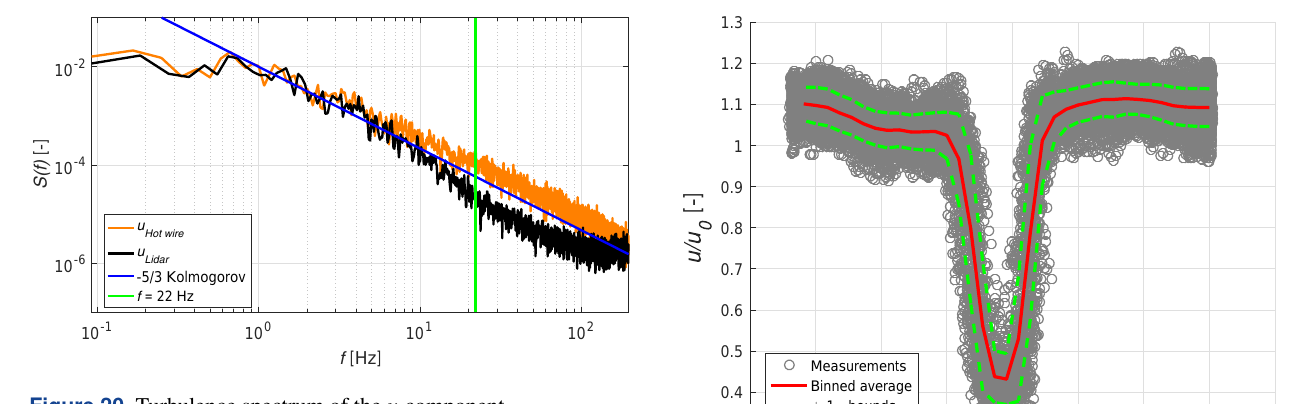
Figure 20. Turbulence spectrum of the u component.